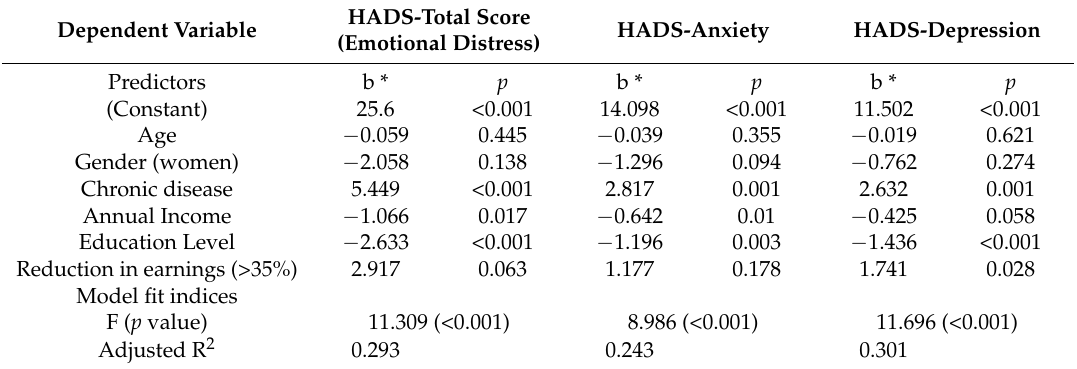
Table 3. Regression analyses of emotional distress, anxiety, and depression on the socioeconomic